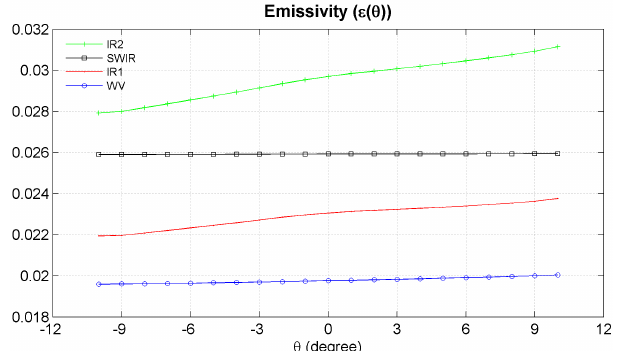
Figure 6. Scan mirror emissivity as a function of scan angle for all four channels. Zero degrees represents the nadir-looking position, negative signs represent the west direction, and positive signs the east direction from the center of the Earth disk. In operation, the scan angle dependence is fitted with a quadratic equation and ap- plied in real